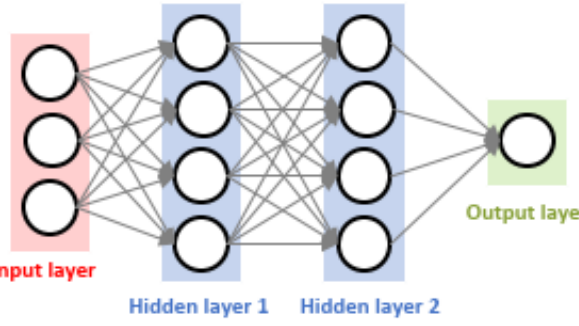
Figure 2. A simple ANN with two hidden layers [20].